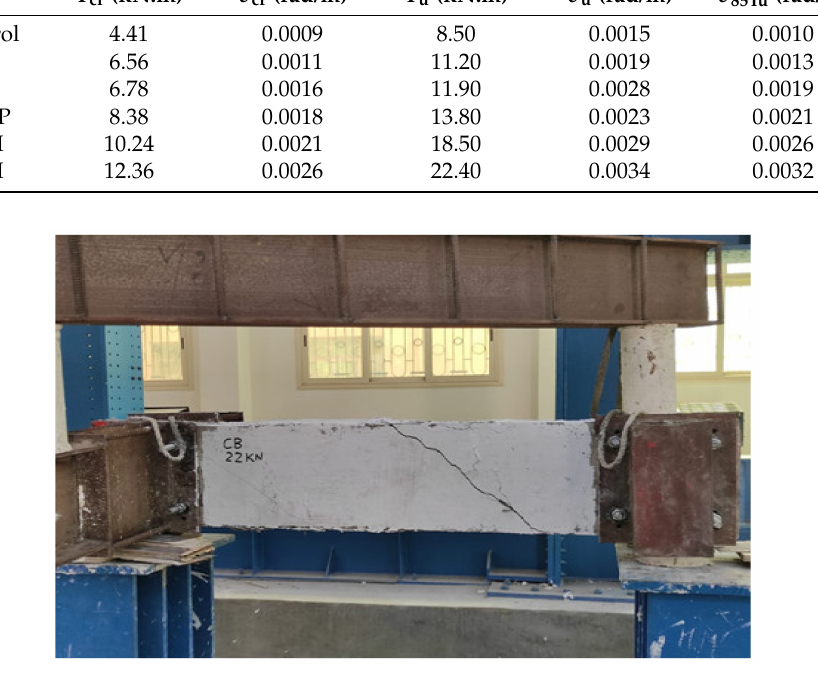
Figure 15. Final crack of beam